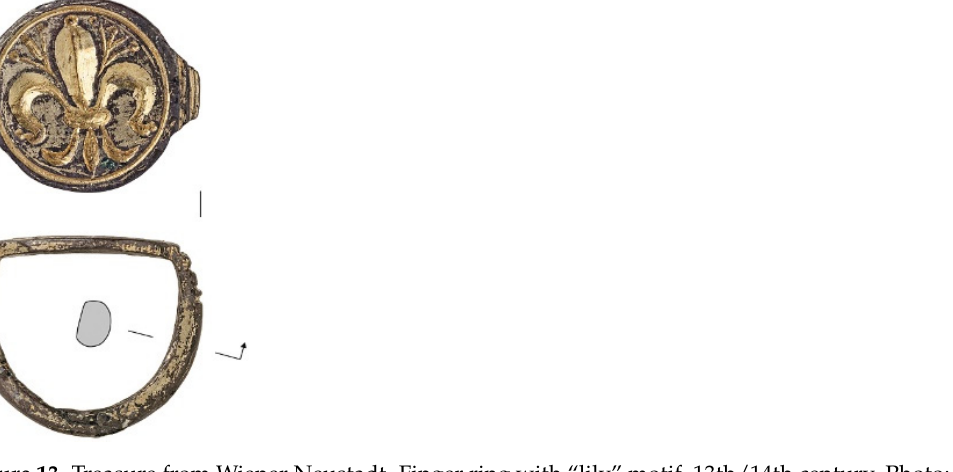
Figure 13. Treasure from Wiener Neustadt. Finger ring with “lily” motif, 13th/14th century. Photo: Paul Kolp; editing: Franz Siegmeth.